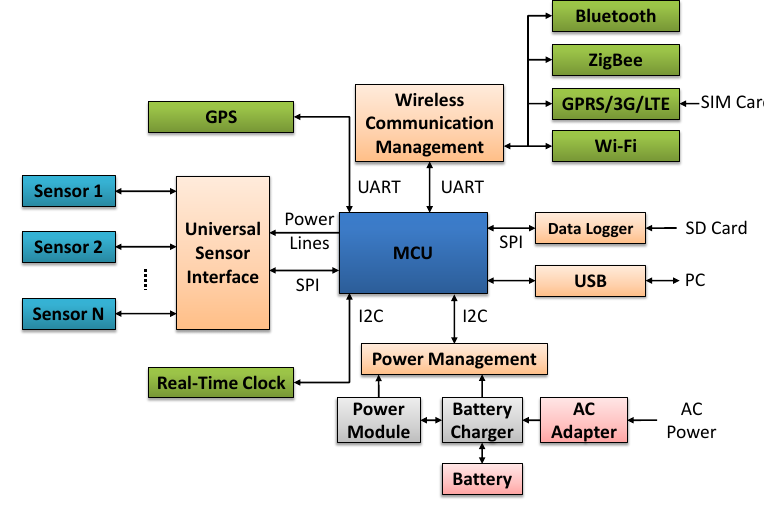
Figure 1. System architecture of a MSS sensor node. (GPS: Global Positioning System; SPI: Serial Peripheral Interface; UART: Universal Asynchronous Receiver/Transmitter; MCU: micro-controller unit; I2C: Inter-Integrated Circuit; GPRS: General Packet Radio Service; 3G: 3rd-Generation; LTE: